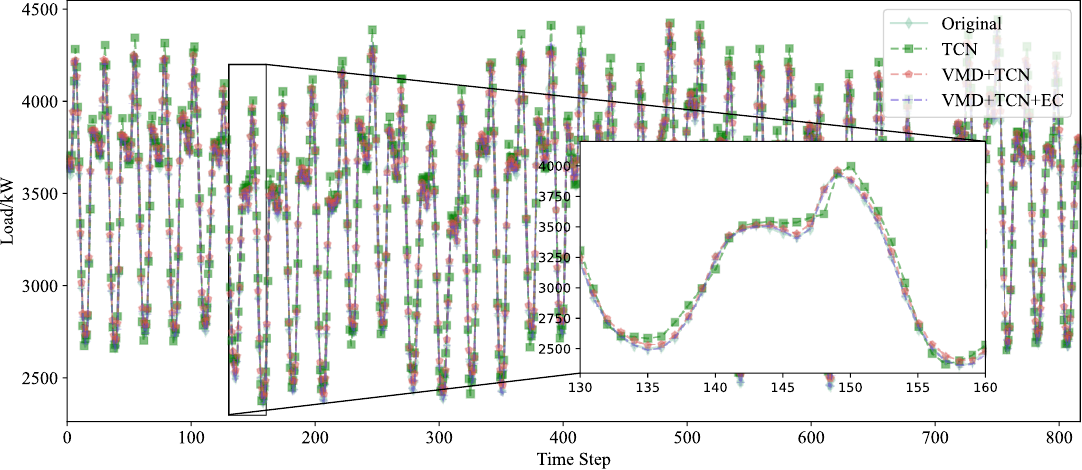
Figure 11. Experimental comparison of different models on the test set.